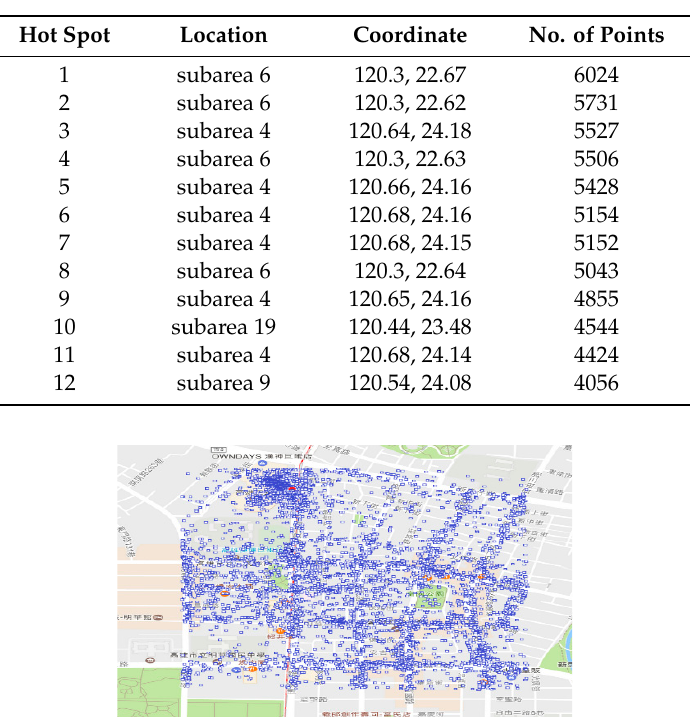
Figure 6. Distribution of points in hot spot one with 6024 points.